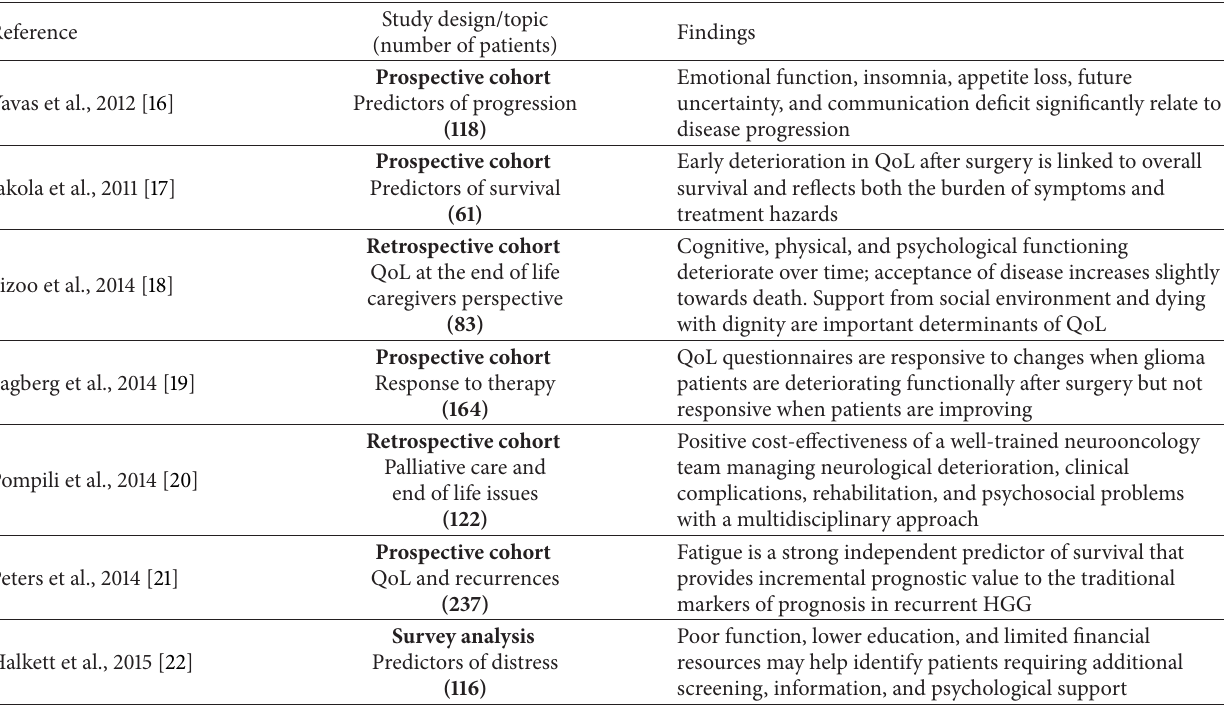
Table 1: QoL studies on HGG.